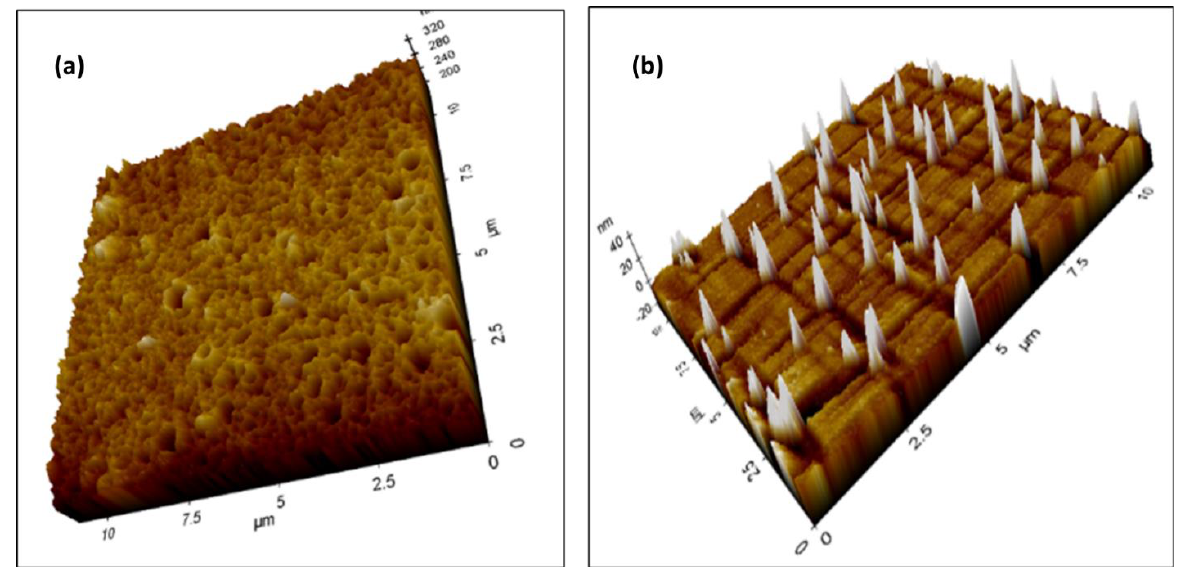
Figure 7. 3D images via AFM analysis ( a ) Illustration of the porosity and ( b ) dispersion of AgNPs throughout the polymeric matrix, scanning over a 10 μm × 10 μm area.